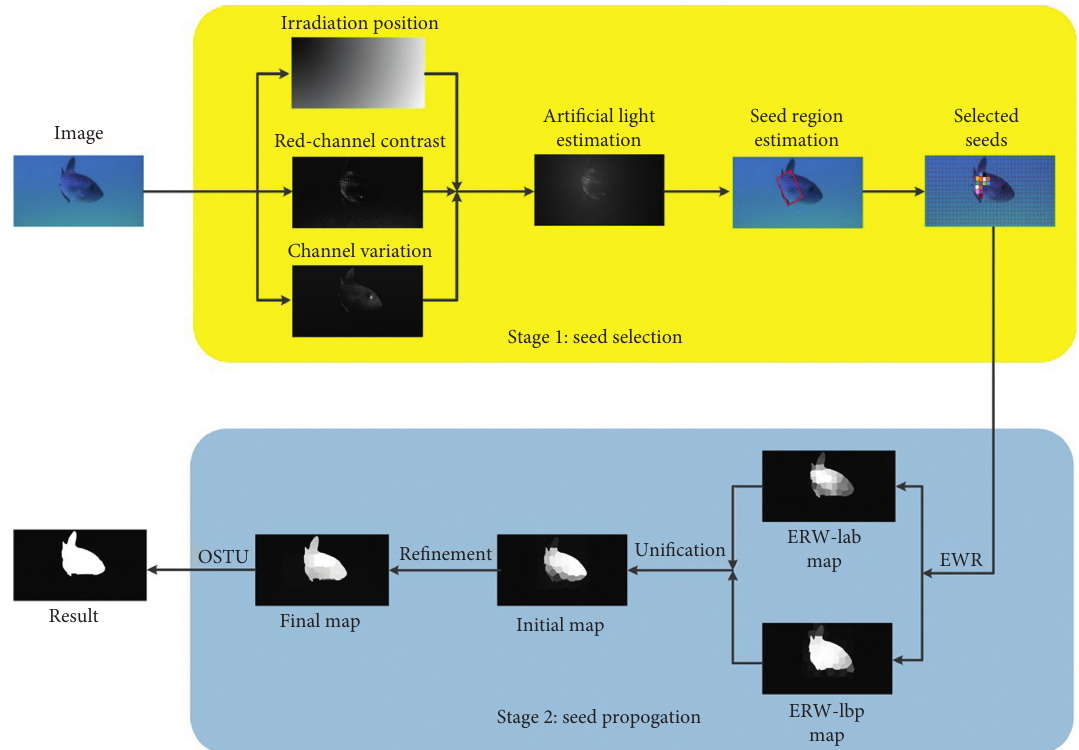
Figure 1: Framework of our proposed approach.